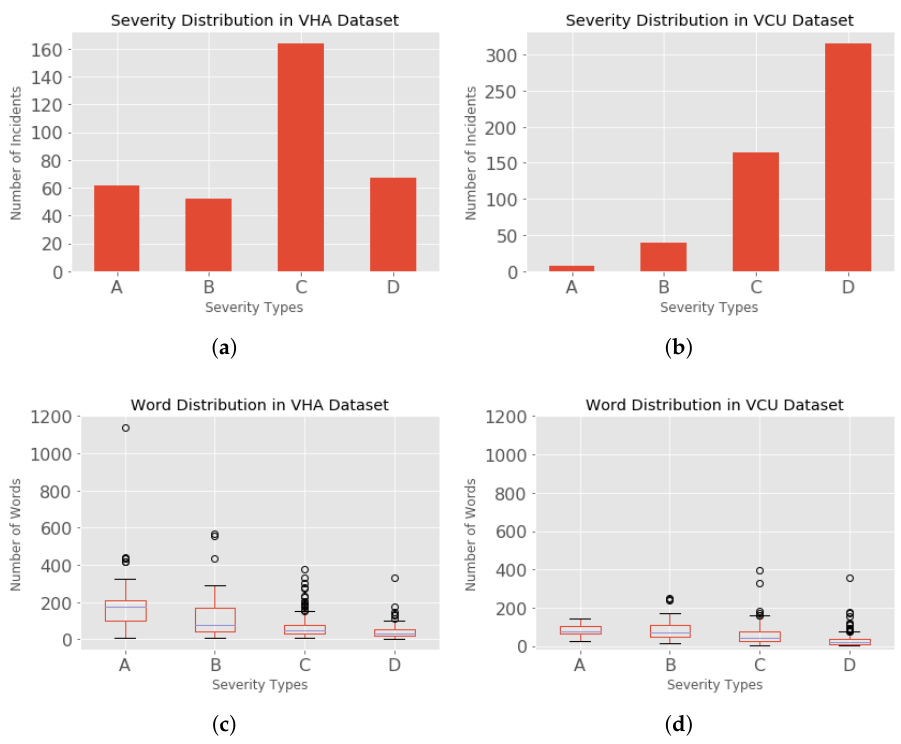
Figure 2. Dataset Distributions: ( a ) Severity Distribution in VHA dataset. ( b ) Severity Distribution in VCU dataset. ( c ) Word Distribution in VHA dataset. ( d ) Word Distribution in VCU dataset.